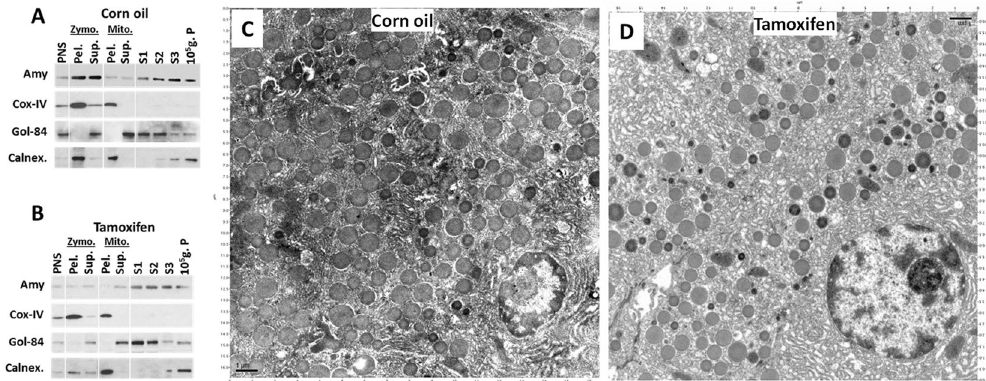
Figure 7. Effect of c-Src knock down on Subcellular localization of amylase and ultrastructure of the pancreatic acinar cell. Subcellular fractionation of pancreas of corn oil ( A ) and tamoxifen ( B ) treated mice, blotted for amylase (Amy), along with the Golgi marker Golgin-84 (Gol-84) and ER marker calnexin (Calnex.). Note that tamoxifen causes loss of amylase in the zymogen fraction along with an increase in the microsomal (S1–10 5 g.P) fractions. Electron micrographs of acinar cells in the pancreas of corn oil ( C ) or Tamoxifen ( D ) treated mice. Note tamoxifen causes an increase in smaller size of zymogen granules, along with an increase in dilated